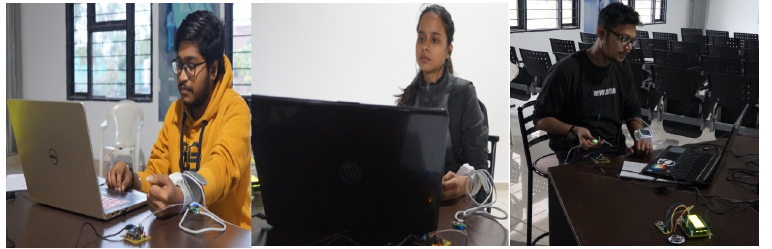
Figure 9. Experimental setup done to capture the facial emotions and physiological sensor values in real-time on different subjects.